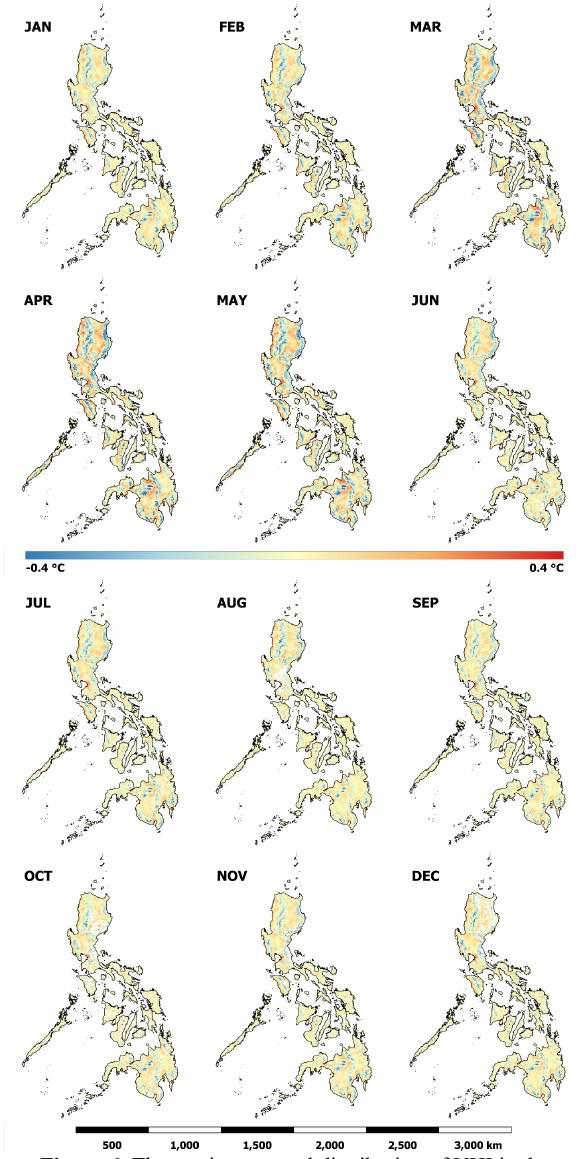
Figure 6. The spatio-temporal distribution of UHI in the Philippines during 2020. It shows that the UHI is intense during the hot dry season (March - April - May). It also shows that the UHI intensity is not equally distributed throughout the country.